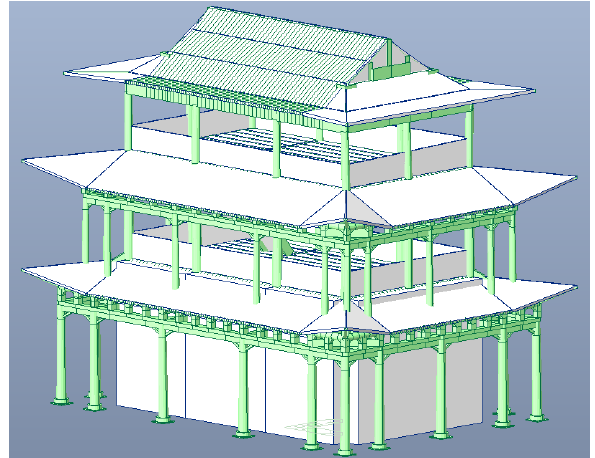
Figure 4. Midas model of Guanghua Pavilion [ 光化楼 ]